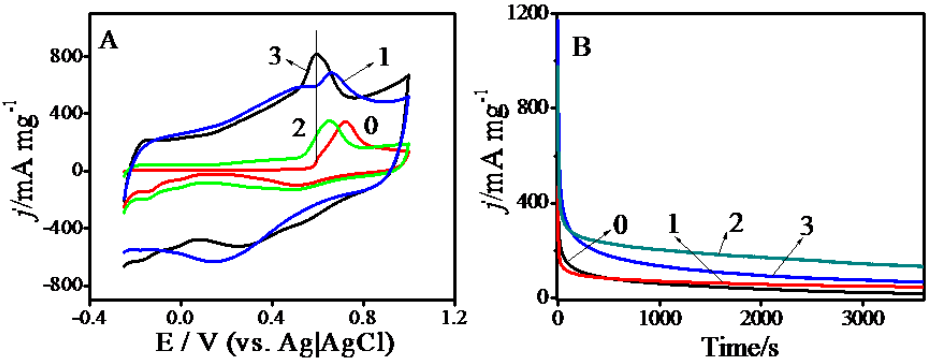
Figure 6. ( A ) CO ‐ stripping voltammograms in 0.5 M H 2 SO 4 : Pt/C ( 0 ), Pt/GNs ( 1 ), Pt/GNs (CS) ( 2 ), Pt/GNs (PAMAM) ( 3 ); ( B ) Chronoamperometric curves in 1 M CH 3 OH + 0.5 M H 2 SO 4 : Pt/C ( 0 ),